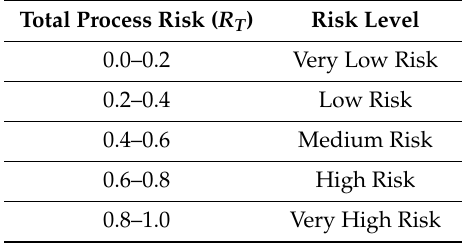
Table 1. Risk scale based on the Hazardous Process Stream Index